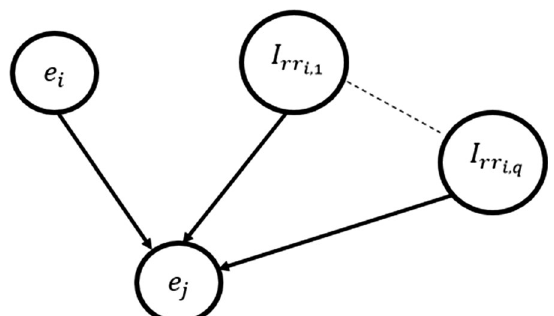
Fig. 4 Bayes Net for the stochastic control of